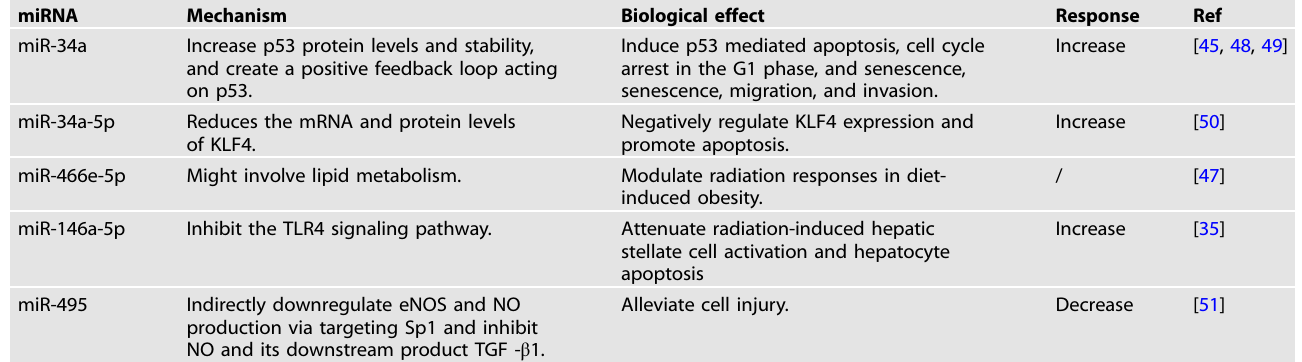
Table 3. MiRNA involved in RILI. miRNA Mechanism